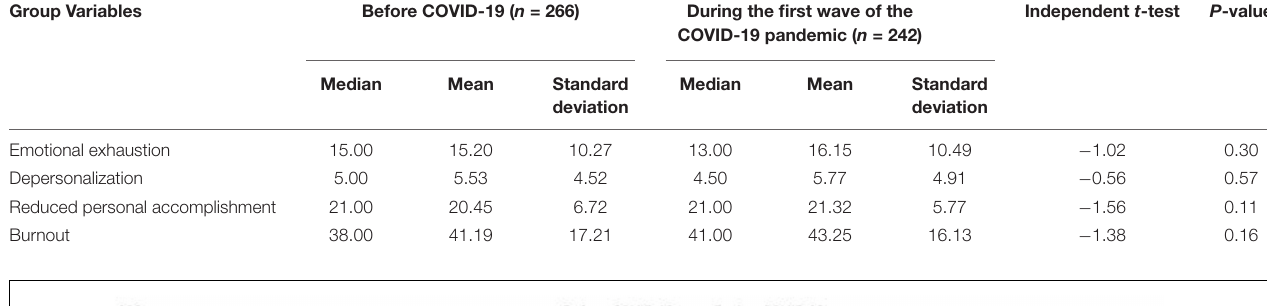
Independent t -test P -value COVID-19 pandemic ( n = 242)